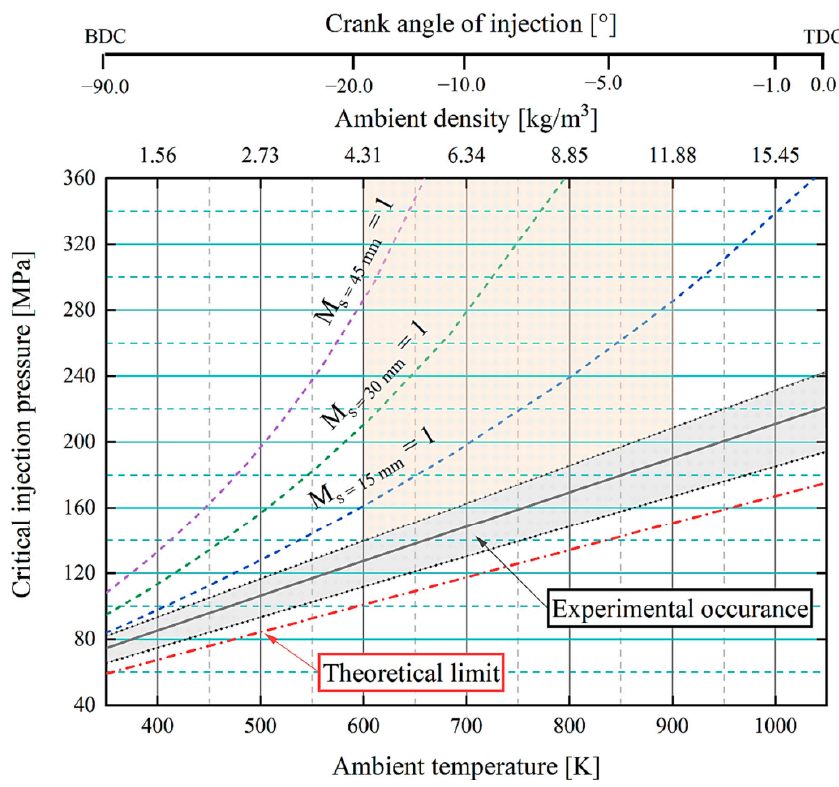
Figure 15. Critical injection pressure to induce a shock wave in a diesel engine. Ambient gas condition: mixture(21%O 2 ; 79%N 2 ); engineconditionsinreference: 350KBDCtemperature, 16 compression ratio, and 1061 K TDC temperature. M s = 15 mm means the Mach number at S = 15